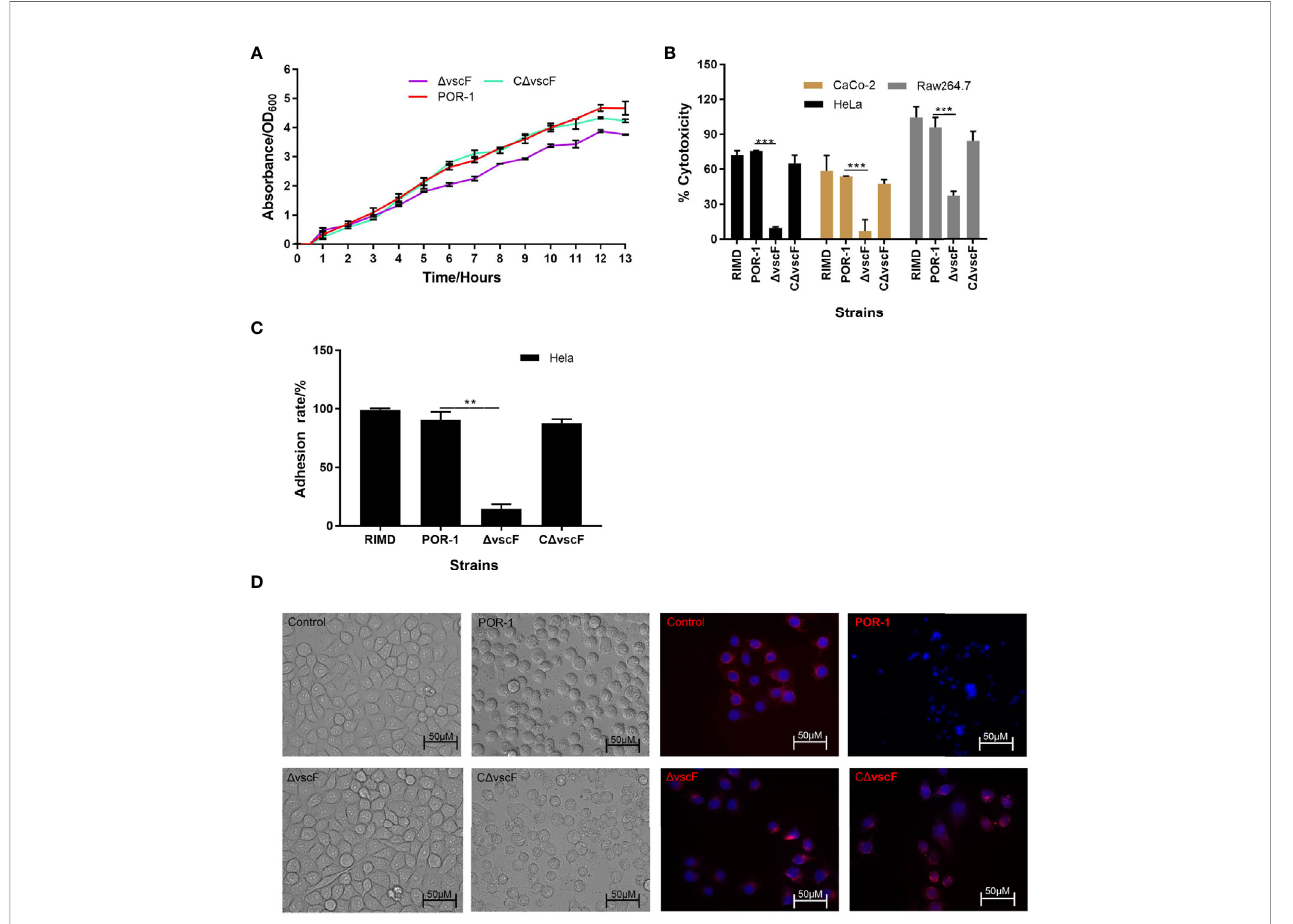
FIGURE 1 | The biological characteristics of WT POR-1, D vscF mutant, and complementation C D vscF strains. Growth curves (A) of V. parahaemolyticus strains were determined with the deletion of the vscF gene. Cytotoxic (B) and adherent (C) abilities of V. parahaemolyticus mutant strains were examined using infected HeLa cells. Values are presented as means and standard deviations from three biological replicates. ** P < 0.01 and *** P < 0.001. HeLa morphology under co- incubation with V. parahaemolyticus strains was observed using an inverted microscope. DNA was stained with DAPI (blue), whereas the cell skeleton was stained with Tubulin-Tracker (red) (D)